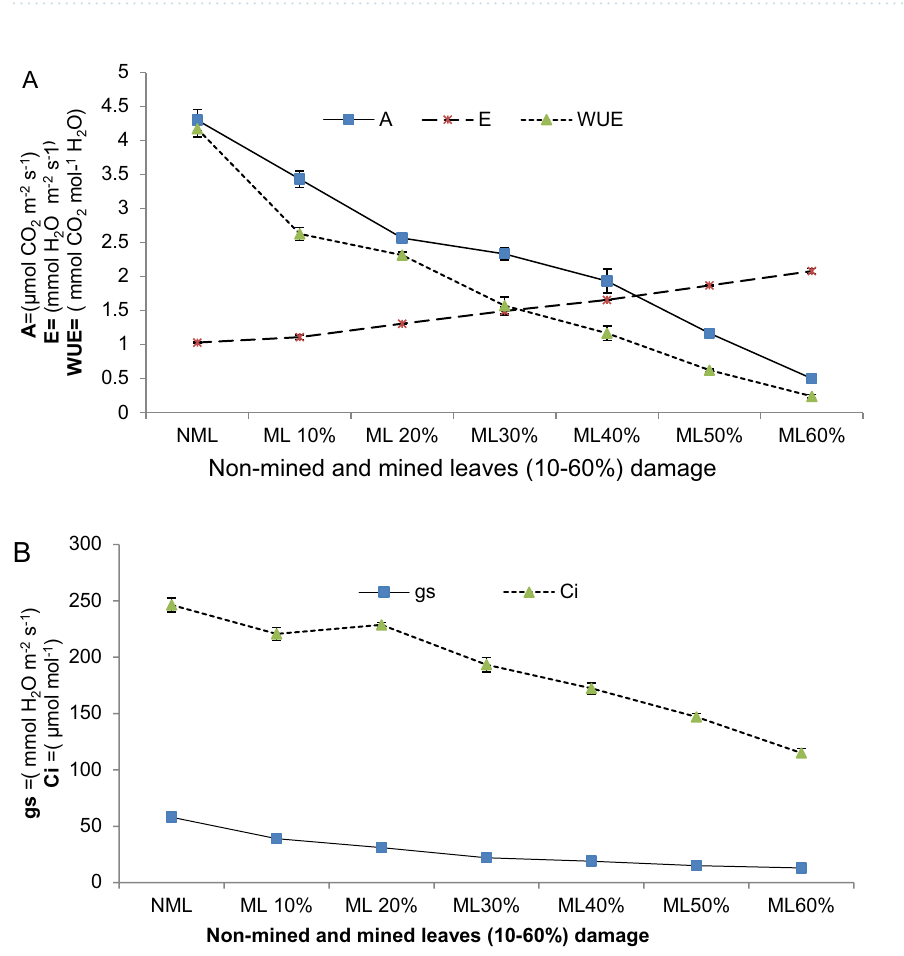
Figure 5. ( A ) Net assimilation rate (A), transpiration (E) & water use efficiency (WUE)and ( B ) stomatal conductance (gs) & sub-stomatal conductance (Ci) of non-mined and mined (different % damaged